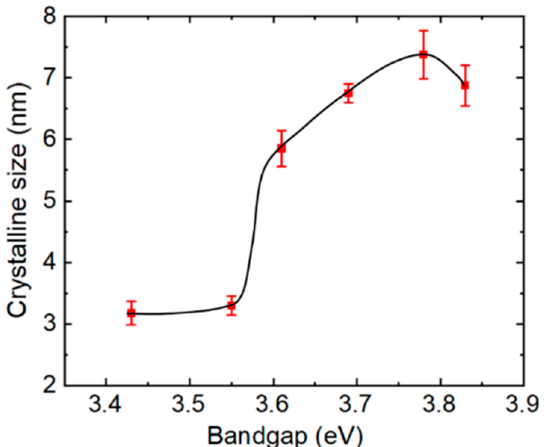
Figure 2. Crystalline size applying the Scherrer equation to the widths of the diffraction peaks for the MZO samples of Figure 1. The error bars are the standard deviations arising from independent measurements from the (002), (101), (102), and (103) diffractions, the four most visible peaks in Figure 1. The line is a guide for the eye.